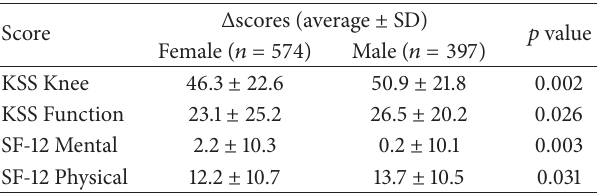
Table 3: Comparison of preop to postop score changes ( Δ